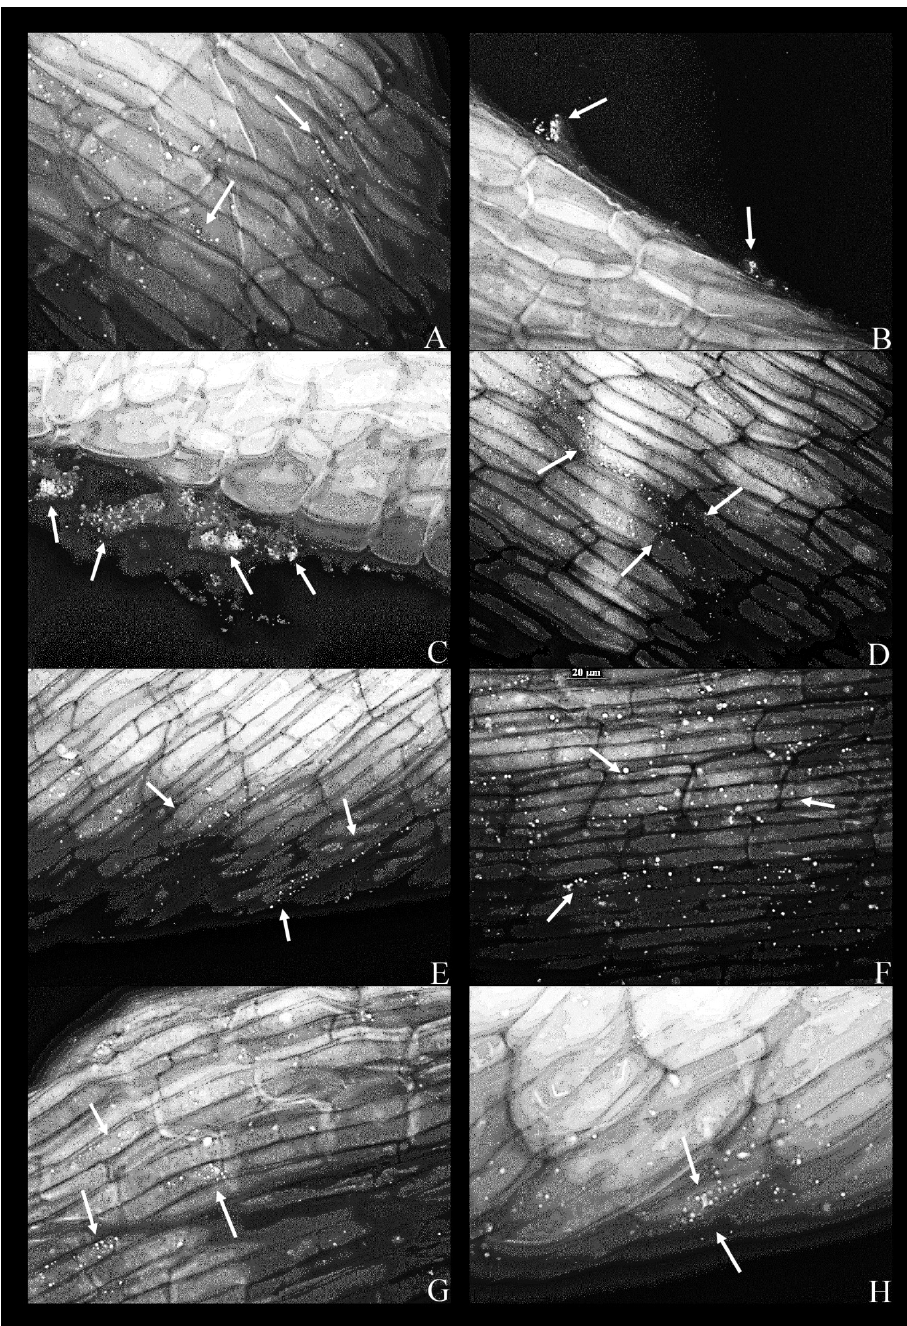
Figure 3. Fluorescent micrographs of duckweed roots in phenol-supplemented (500 mg L − 1 ) MS medium with bacterial strains: ( A ) 11— Lelliottia sp., bacterial cells scattered on the root surface(arrows); ( B ) 14— Klebsiella oxytoca , dense groups of bacterial cells near the root surface (arrows); ( C ) 14— K. oxytoca (63 × ), dense aggregates of bacterial cells (indicated by arrows) near the regions of the root destroyed by pressure (squashing); ( D ) 27— Serratia marcescens , bacterial cells organized along the lines between epidermal cells of the root (arrows); ( E ) 37— Hafnia alvei , bacterial cells organized on the root surface and along the lines of cell–cell boundaries (arrow); ( F ) 43— H. paralvei , bacterial cells on the root surface; ( G ) 51— S. nematodiphila , scarce bacterial cells on the root surface; ( H ) 51— S. nematodiphila , magnified 63 × to show a typical microcolony on the root surface. Magnification: 40 × , unless stated otherwise. Arrows: bacterial cells on the root